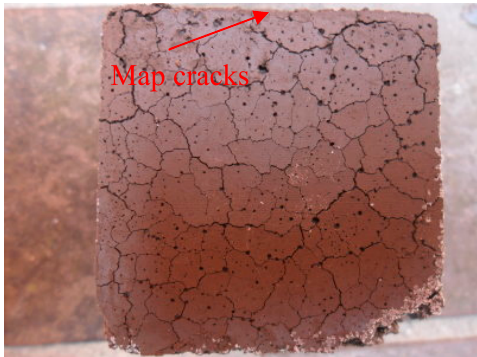
Figure 9. Image of B5 specimen showing obvious cracking.